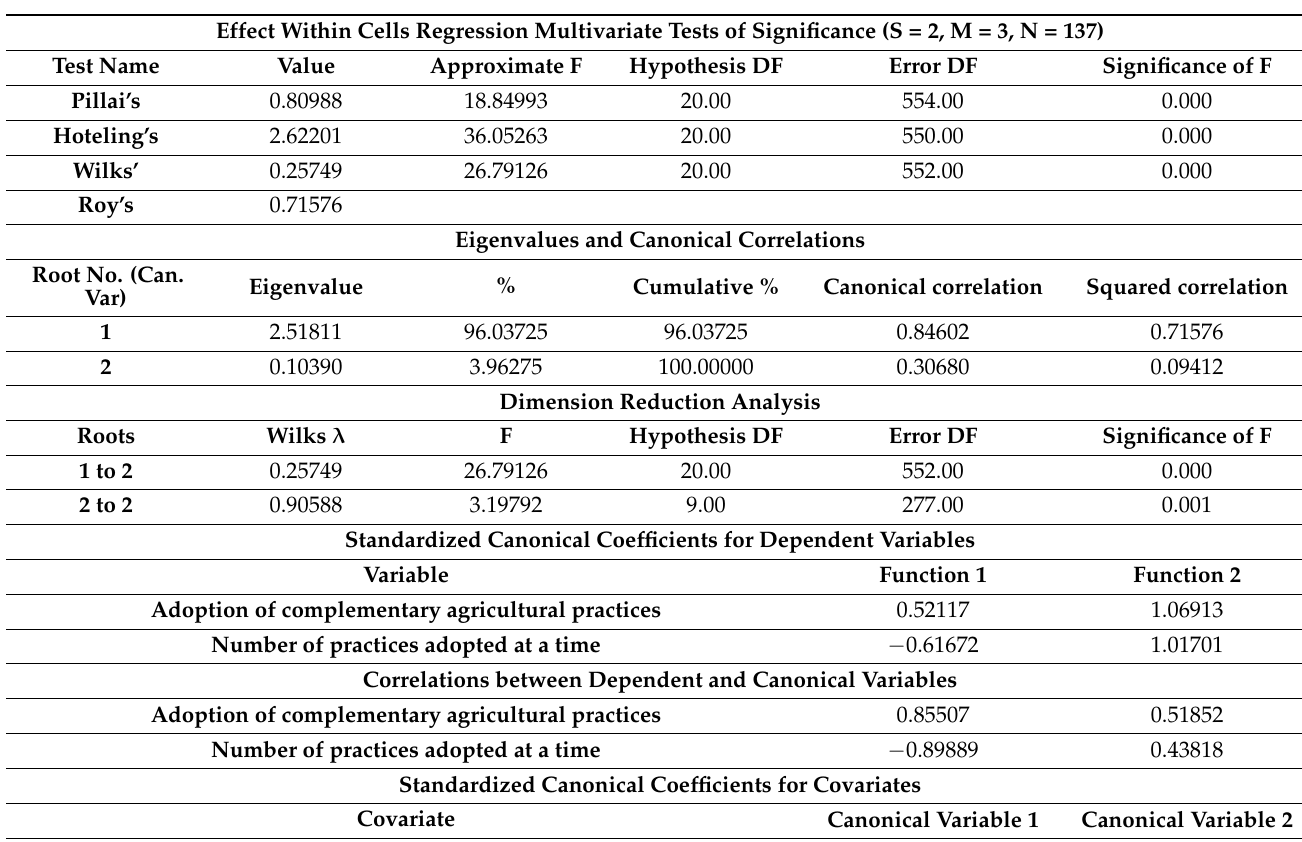
Table A2. Results from the multivariate model using canonical correlation